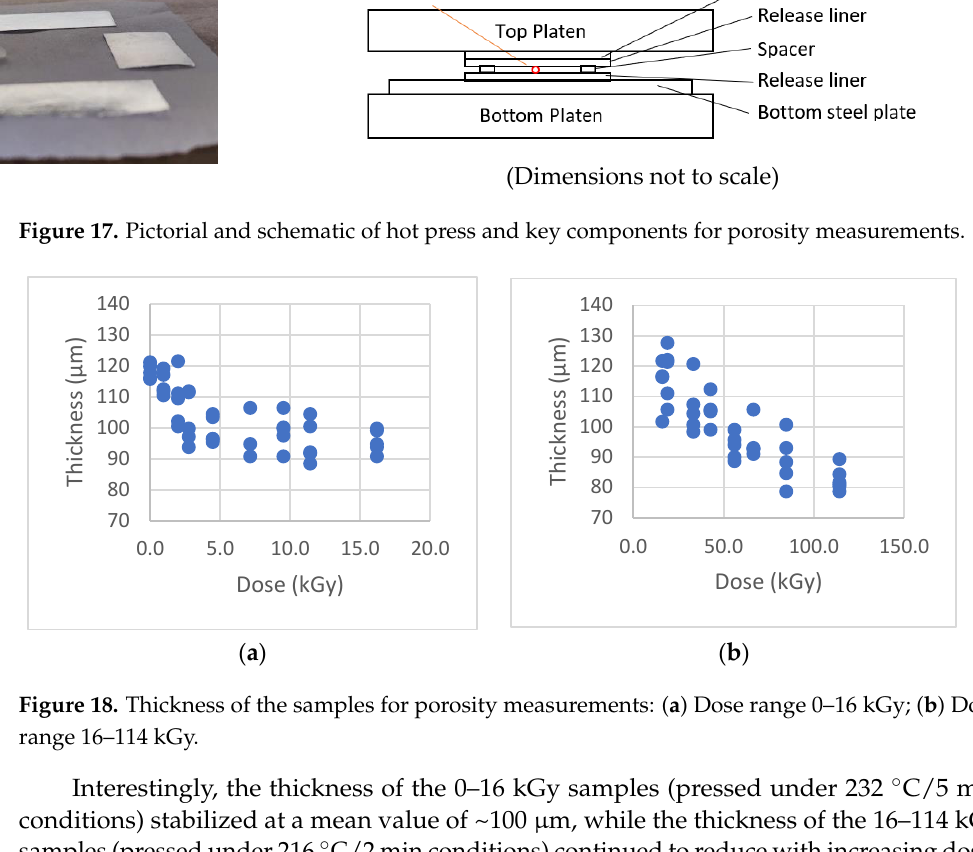
Figure 19. The blue dots are indicators marking the grid locations to be measured for porosity. Two samples were measured at each selected dose.